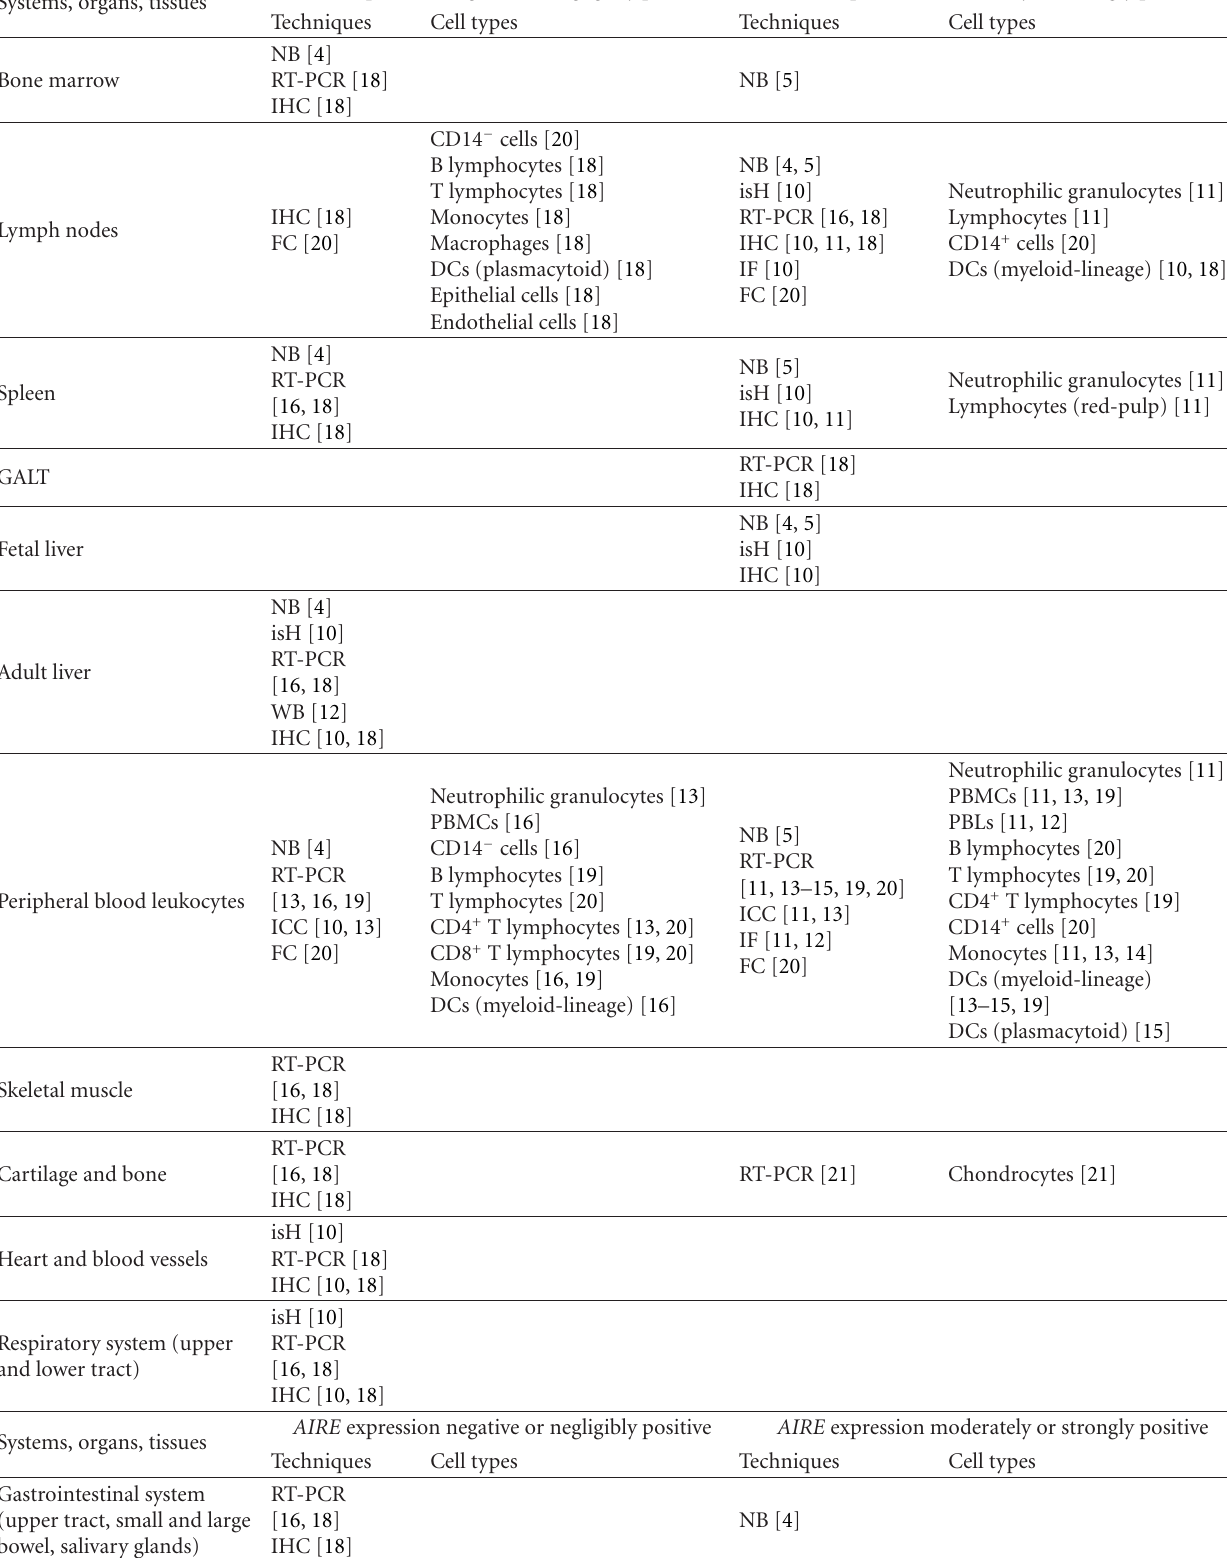
Table 1: AIRE expression ( AIRE mRNA and AIRE protein) in human extra-thymic systems, organs, and tissues. Systems, organs,